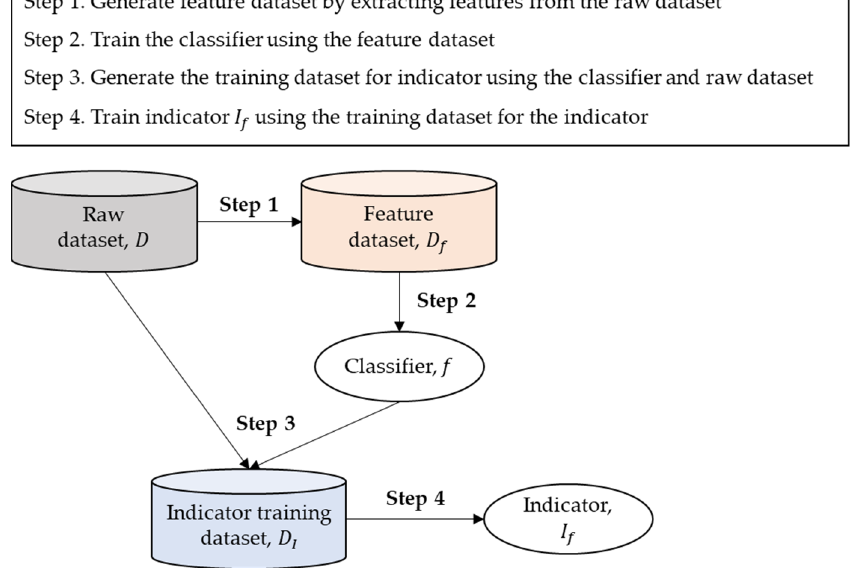
Figure 4. Learning framework for the proposed indicator.